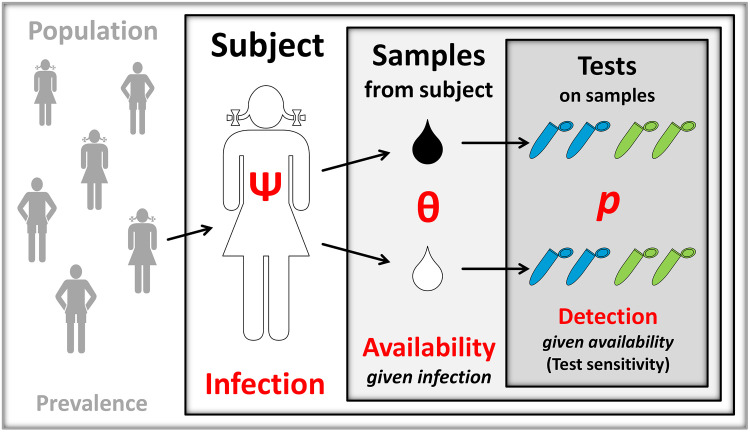
The biologically hierarchical problem of detecting a pathogen in its hosts.A subject drawn from a population is infected with the pathogen with probability Ψ (which reflects the prevalence of infection in that population). A sample drawn from a subject contains the pathogen with probability θ, which is conditional on Ψ. Therefore, θ represents sample-level pathogen (or, more broadly, target) availability, given subject-level infection. Finally, pathogen detection tests run on samples drawn from a subject detect the target with a probability p that is conditional on θ; therefore, p represents test-level probability of detection, given sample-level availability (and, hence, subject-level infection). This shows that the biological problem of detecting a pathogen in its hosts involves a hierarchy of nested levels: subjects (within populations), samples within subjects, and tests within samples. To understand how the system works, we therefore need to estimate 3 probabilities: test-level detection (p), sample-level availability (θ), and subject-level infection (Ψ). Replicate tests inform on the value of p (which is, strictly speaking, the sensitivity of the test) and replicate samples (possibly encompassing different tissues or bodily fluids, as suggested by black/white drops) drawn from the same subject inform on the value of θ; this opens the possibility of estimating Ψ and, therefore, prevalence in the population. Note that all the parameters above (Ψ, θ, and p) are probabilities and hence can take on any value between 0 and 1.